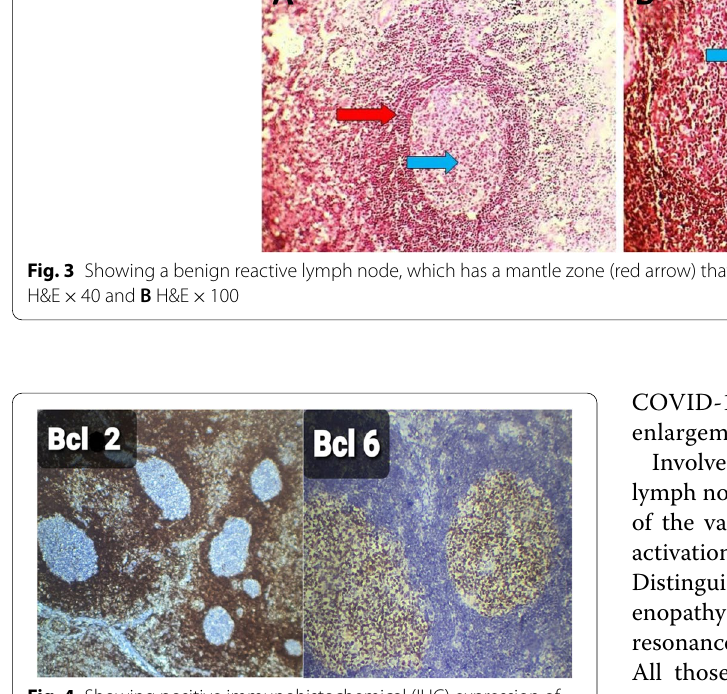
Fig. 4 Showing positive immunohistochemical (IHC) expression of BCL‑2 in the mantle zones and negative brownish discoloration of the nuclear and cytoplasmic stain. Besides, positive IHC expression of BCL‑6 in the germinal centers of the lymph node with reactive hyperplasia, with a brownish discoloration of the nuclear